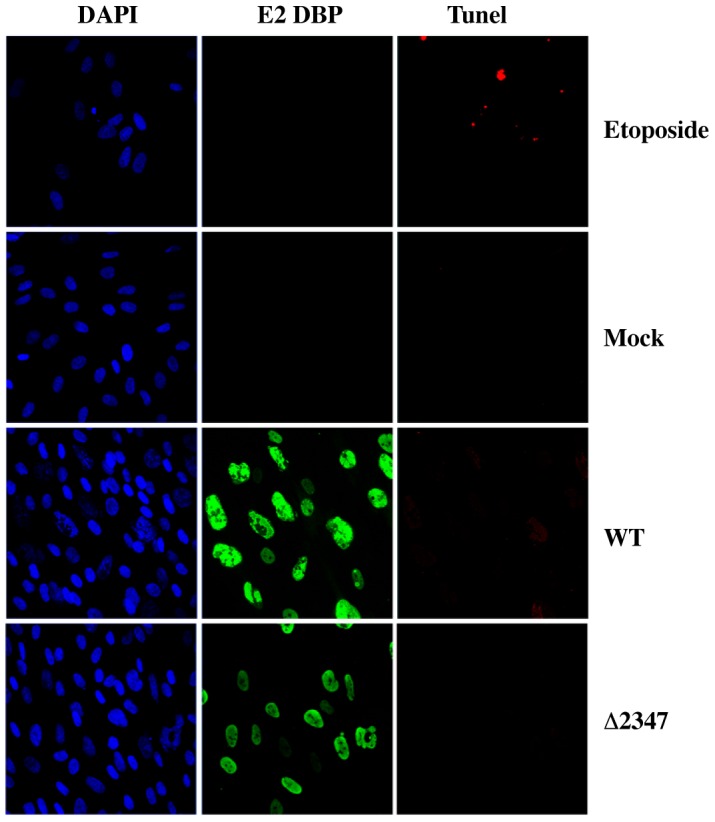
Apoptosis is not induced in FIN-treated, infected cells.IFN-treated HFFs grown on coverslips were infected with AdEasyE1 (WT) or AdEasyE1Δ2347 (Δ2347) for 34 hrs, or treated with etoposide as a positive control. Double strand breaks in DNA (red) were detected by using a TUNEL assay, as described in Materials and Methods. Immunostaining for DBP (green) was used as a marker of infection. Cells were Hoechst stained (blue), and single xy-planes visualized by confocal microscopy.